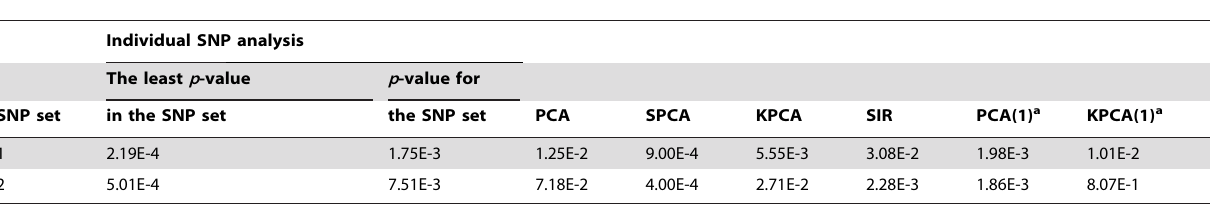
Table 8. Results of four methods on the analysis of the SNP set from the GWAS study.